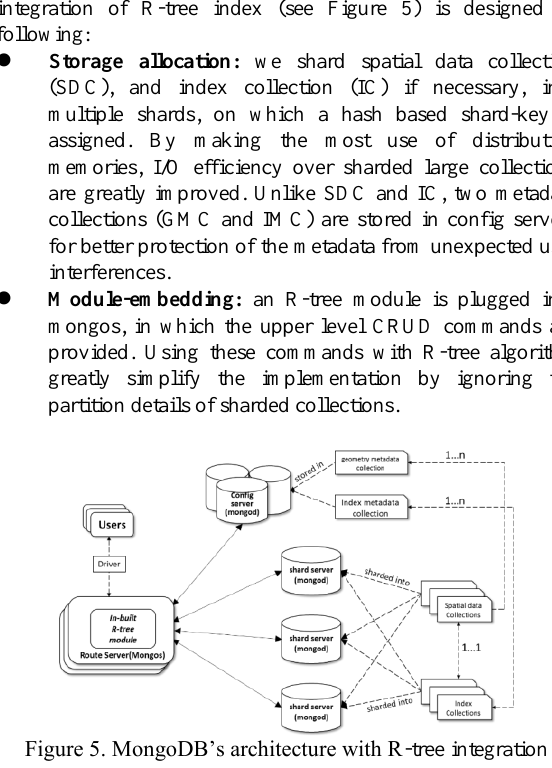
Figure 4. Procedures of R-tree related operations